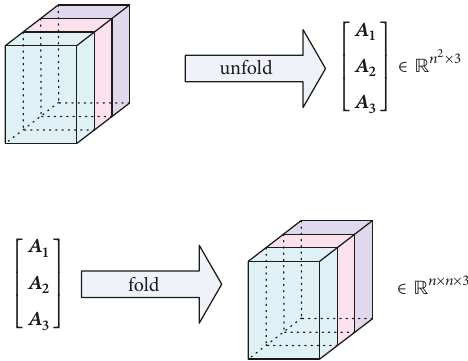
Figure 1: Example of the unfold and fold